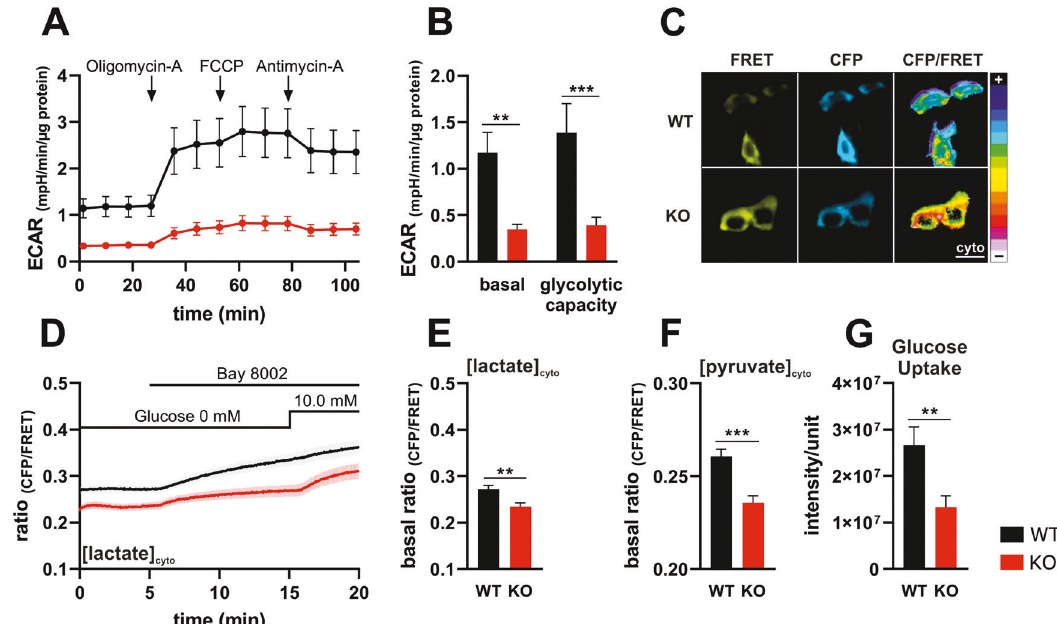
Fig. 1 IK de fi ciency impairs glycolytic activity. A Extracellular acidi fi cation rates (ECAR) of MMTV-PyMT WT (black line and circles) and MMTV- PyMT IK KO cells (red line and circles) over-time in response to administration of Oligomycin-A, FCCP, or Antimycin-A as indicated in the panel. Data represents average ±SEM of n = 3 independent experiments per genotype. B Basal ECAR (timepoints 0 – 30, left) and glycolytic capacity (right) of MMTV-PyMT WT (black bars) and MMTV-PyMT IK KO cells (red bars). Bars represent average ±SEM, n = 3 with ** p ≤ 0.01 and *** p ≤ 0.001, unpaired t -test. C Representative FRET (yellow, left), CFP (cyan, middle) and pseudocoloured FRET-ratio images (16-colors, right) and D FRET-ratio signals over-time of MMTV-PyMT WT (black) and MMTV-PyMT IK KO cells (red) expressing Laconic , a FRET-based lactate indicator ([lactate] cyto ). At time point indicated in the panel, either the MCT-inhibitor BAY-8002 or 10.0 mM of glucose were administered to the cells. Data represents average ±SEM, n = 5. Scalebar = 20 µm. E Basal FRET-ratio signals (timepoints 0 – 5 in D ) of MMTV-PyMT WT (black bar) and MMTV-PyMT IK KO cells (red bar) expressing the FRET-based lactate indicator. Bars represent average ±SEM, n = 5 with ** p ≤ 0.01, unpaired t -test. F Basal FRET-ratio signals (timepoints 0 – 5) of MMTV-PyMT WT (black bar) and MMTV-PyMT IK KO cells (red bar) expressing Pyronic , a FRET-based pyruvate indicator ([pyruvate] cyto ). Bars represent average ±SEM, n = 5 (WT), 6 (KO) with *** p ≤ 0.001, unpaired t-test. G Glucose uptake rates of MMTV-PyMT WT (black bar) and IK KO cells (red bar), analyzed using 2-NBDG, a fl uorescent glucose analog. Data represent average ±SEM from n = 5 independent experiments per